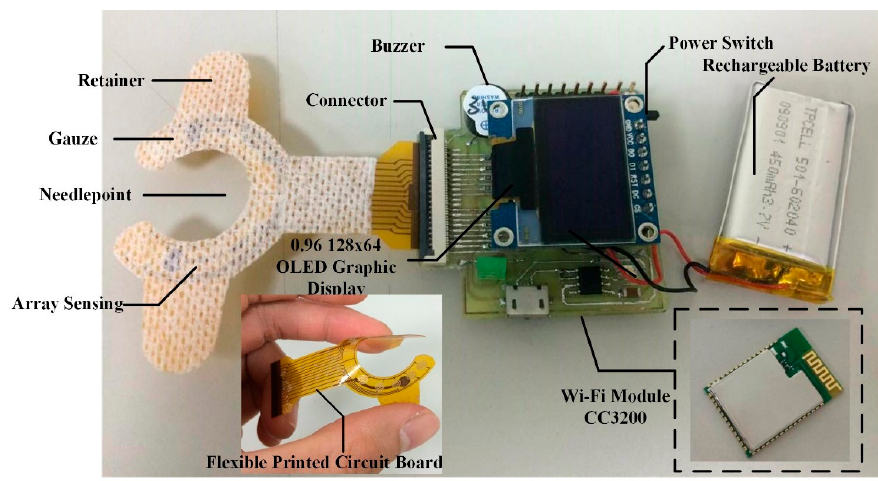
Figure 4 . Photograph of the blood leakage detector.